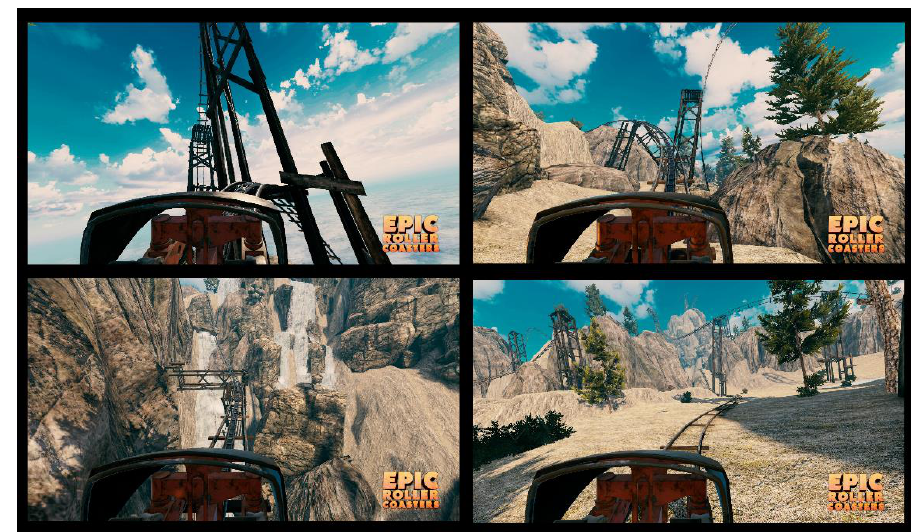
Figure 1. Example images from “Epic Roller Coaster” by B4T Games.